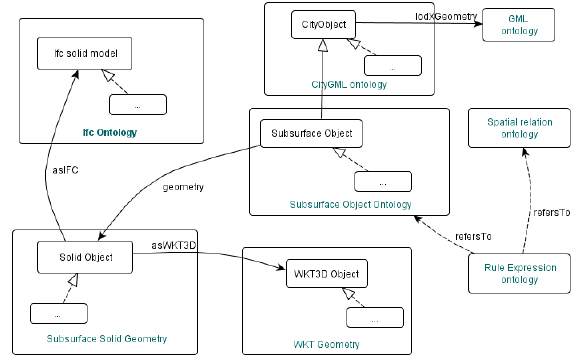
Figure 4. Ontologies architecture and